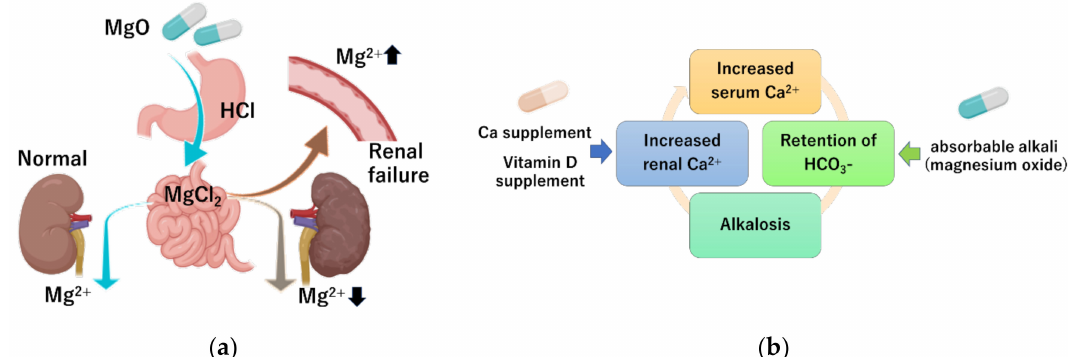
Figure 2. Mechanism of hypermagnesemia and milk–alkali syndrome. ( a ) In patients with impaired renal function, poor magnesium excretion increases the risk of hypermagnesemia. ( b ) Simultaneous intake of excessive calcium and magnesium oxide, which is a non-absorbable alkali, can increase the serum calcium